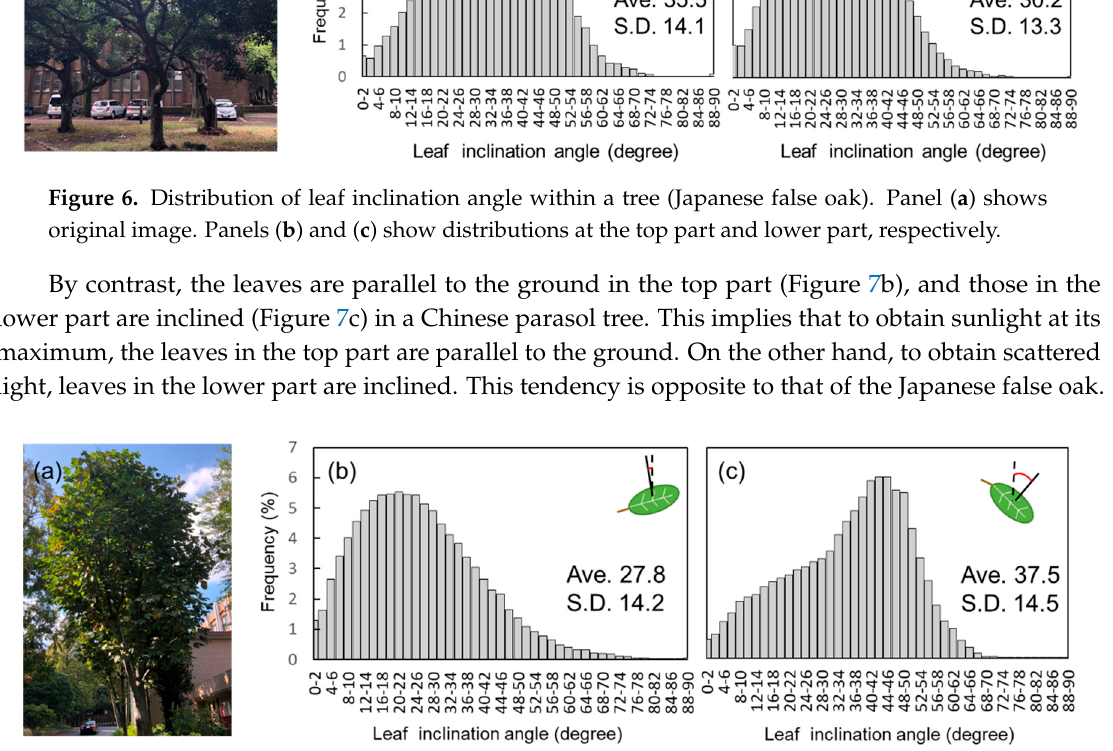
Figure 7. Distribution of leaf inclination angle within a tree (Chinese parasol tree). Panel ( a ) shows original image. Panels ( b ) and ( c ) show distributions at the top part and lower part, respectively.